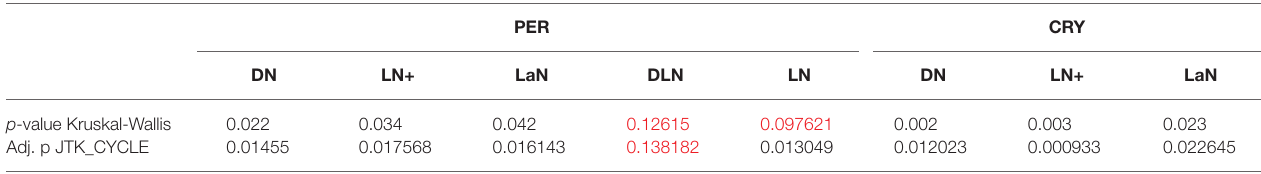
TABLE 1 | All clusters oscillate in a daily manner, except for the DLN. PER CRY DN LN+ LaN